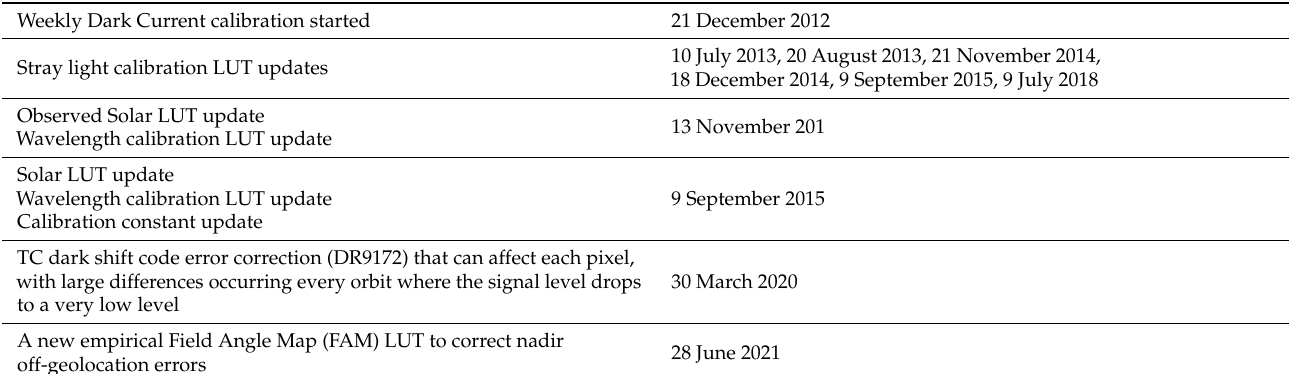
Table A2. Timeline for the S-NPP/OMPS/NM calibration LUTs updates.